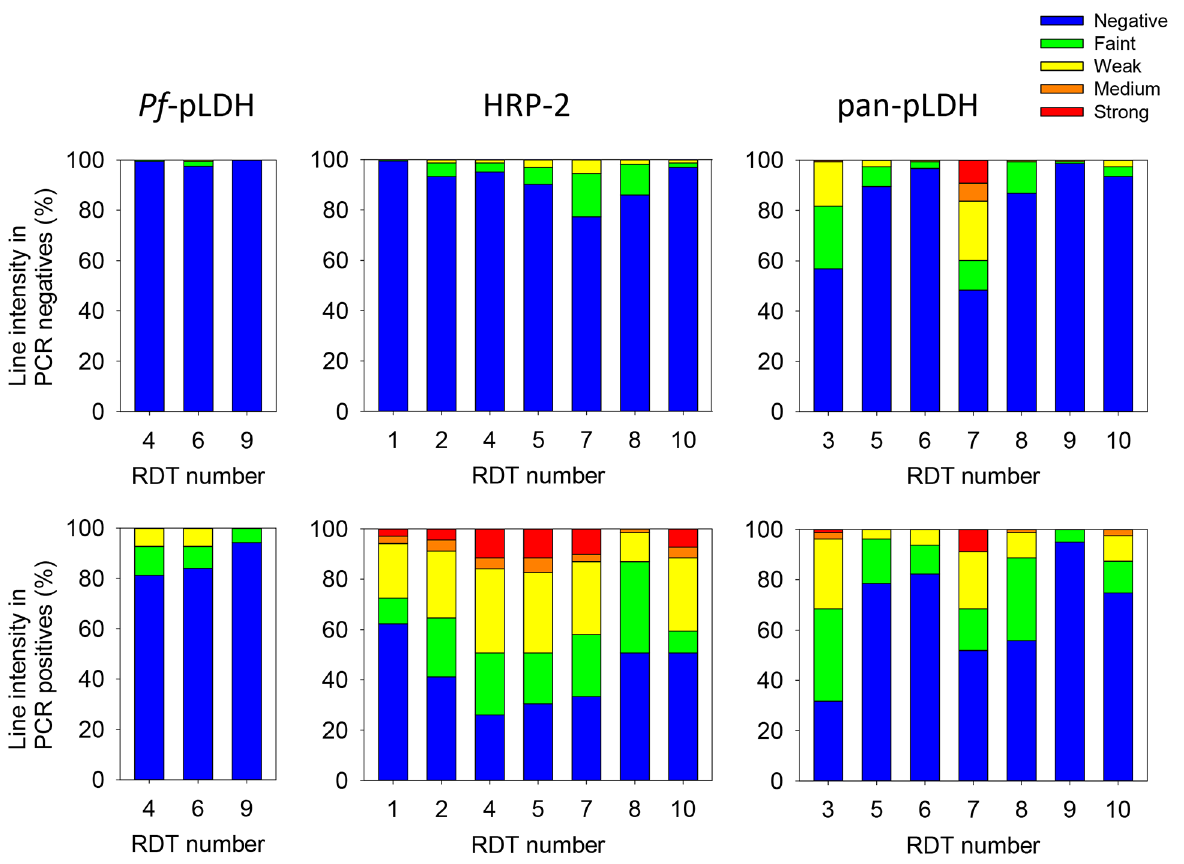
Figure 1. Line intensities for Pf-pLDH, HRP-2 and pan-pLDH in PCR negative and positive study participants. Pf-pLDH: left, HRP-2: middle, pan-pLDH: right. PCR negative: upper panels, PCR positive: lower panels. RDT number: 1 u Paracheck Pf; 2 u ICT Malaria Pf Cassette Test; 3 u Advantage Pan Malaria Card; 4 u Malaria Antigen Pf (HRP-2/pLDH); 5 u SD malaria Ag Pf/Pan; 6 u SD Malaria Antigen Pf; 7 u ICT Malaria Combo Cassette Test; 8 u Carestart Malaria HRP2/pLDH (Pf/Pan) Combo Test; 9 u Carestart Malaria pLDH (Pf/pan); 10 u First Response Malaria Ag (pLDH/HRP2) Combo Rapid Diagnostic Test.